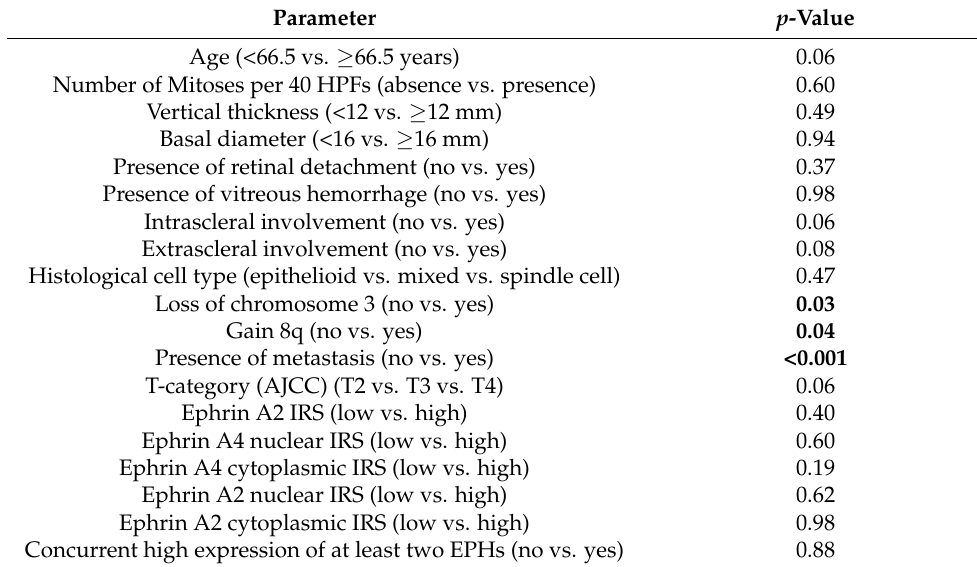
Table 5. Results of univariate survival analysis (log-rank test). Parameter p -Value Age (<66.5 vs. ≥ 66.5 years) 0.06 Number of Mitoses per 40 HPFs (absence vs. presence) 0.60 Vertical thickness (<12 vs. ≥ 12